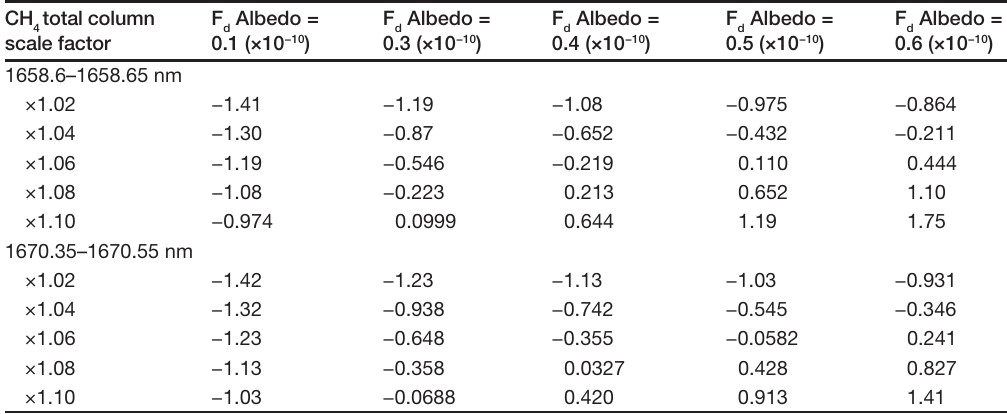
(Equation 5) values summarised for the standard conditions expressed in Table 3. Spectral average F d Table 2. The F values are shown for each Ch scale given the range of reflectances indicated in Table d 4